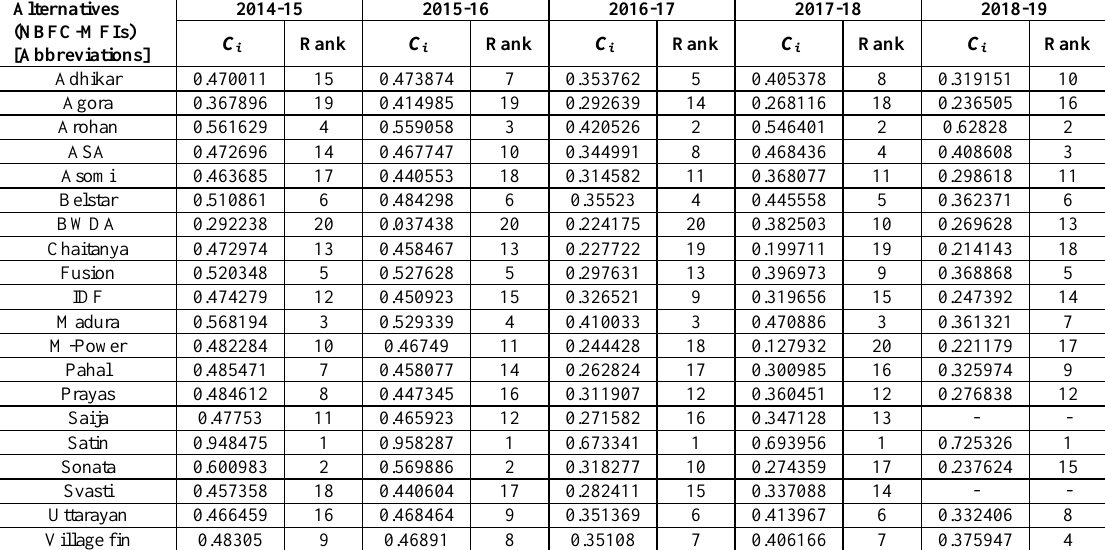
Table 3. Closeness coefficients and ranks of the alternatives for each